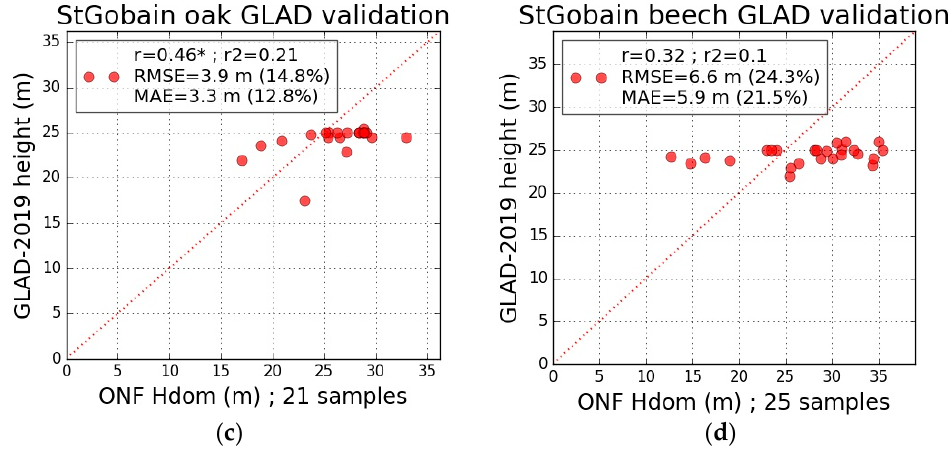
Figure 3. GLAD-2019 height map validation using plot measurement. ( a ) Orléans, oak; ( b ) Orléans, Scots pine; ( c ) StGobain, oak; ( d ) StGobain, beech. Statistical signicicance: * p ≤ 0.05.